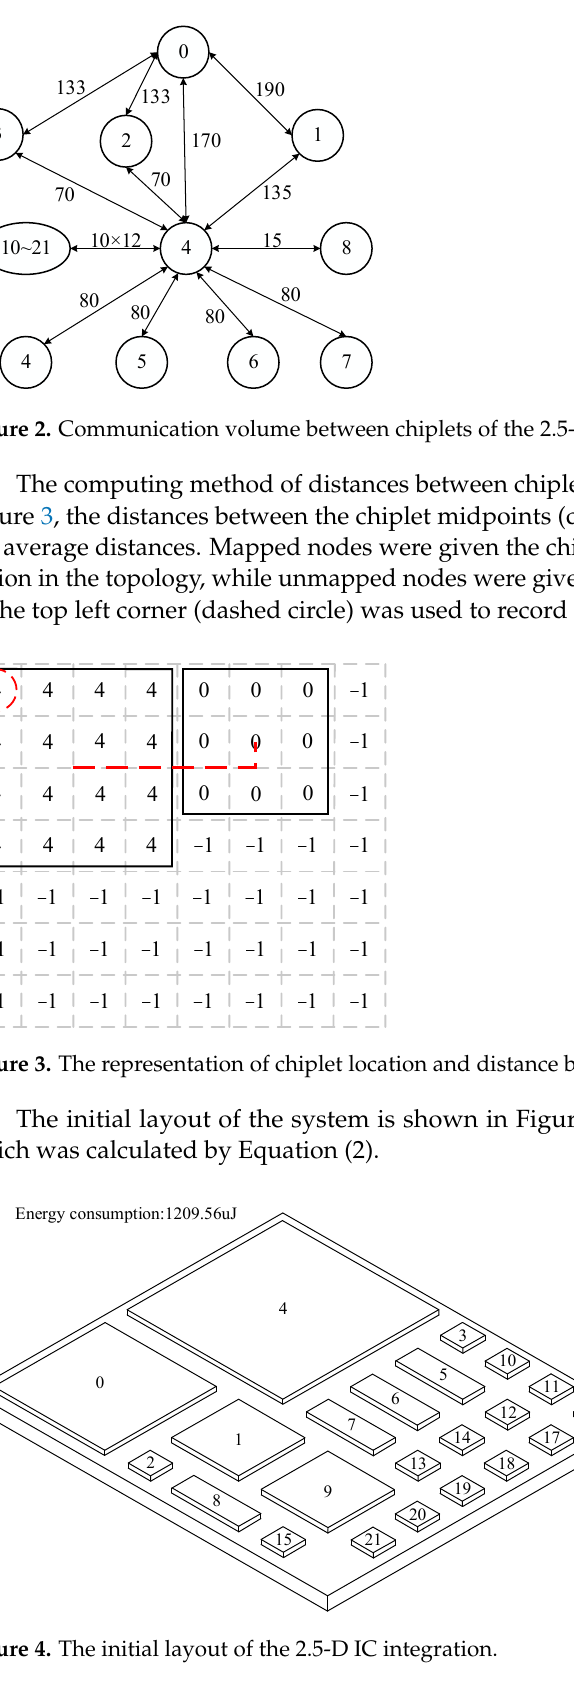
Figure 2. Communication volume between chiplets of the 2.5-D IC integration.